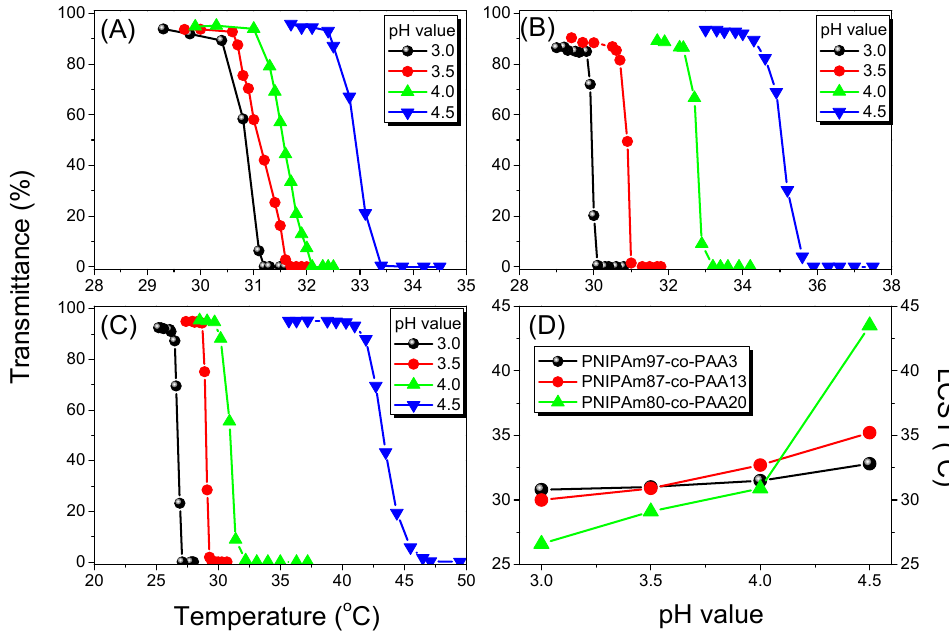
Figure 6. ( A – C ) Transmittance, based on UV–Vis spectra, at 550 nm of aqueous solutions at various temperatures and values of pH for: ( A ) PNIPAAm97- co -PAA3; ( B ) PNIPAAm87- co -PAA13; and ( C ) PNIPAAm80- co -PAA20 random copolymers. ( D ) Corresponding LCSTs of aqueous PNIPAAm- co -PAA solutions at various values of pH.